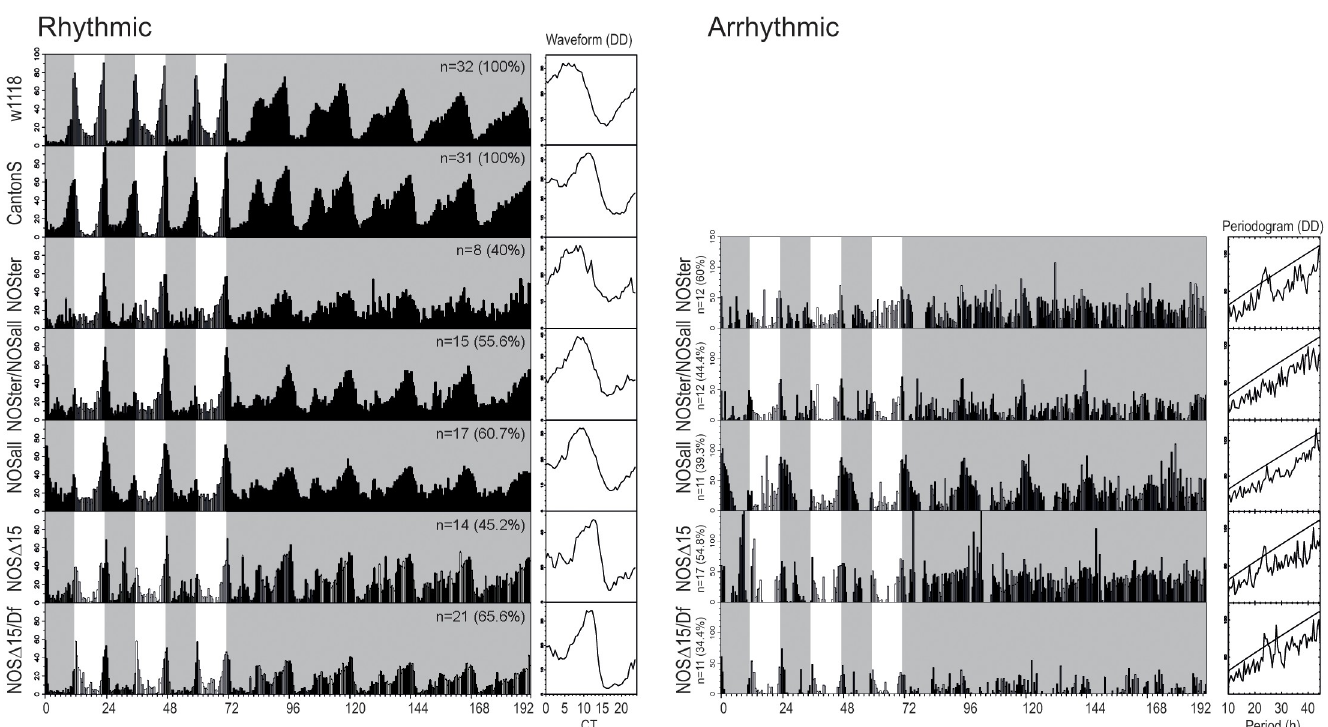
Fig 2. NOS deletion impairs the circadian behavior in constant darkness. The locomotor activity of w 1118 , Canton-S and NOS homozygous, transheterozygous and hemizygous mutants in LD and DD. Left, group-average locomotor activity and mean waveforms of rhythmic flies. Right, representative actograms and periodgrams demonstrating arrhythmic locomotor activity of NOS mutant